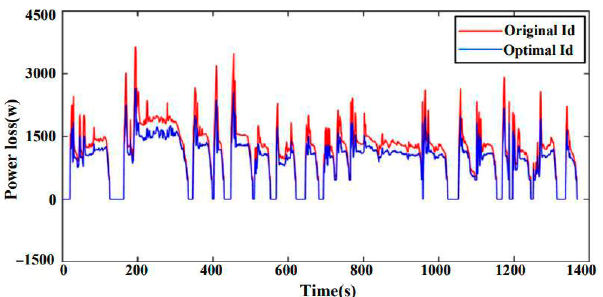
Figure 26. Comparison of power losses between the system with the original identifier and the system with the optimal identifier.